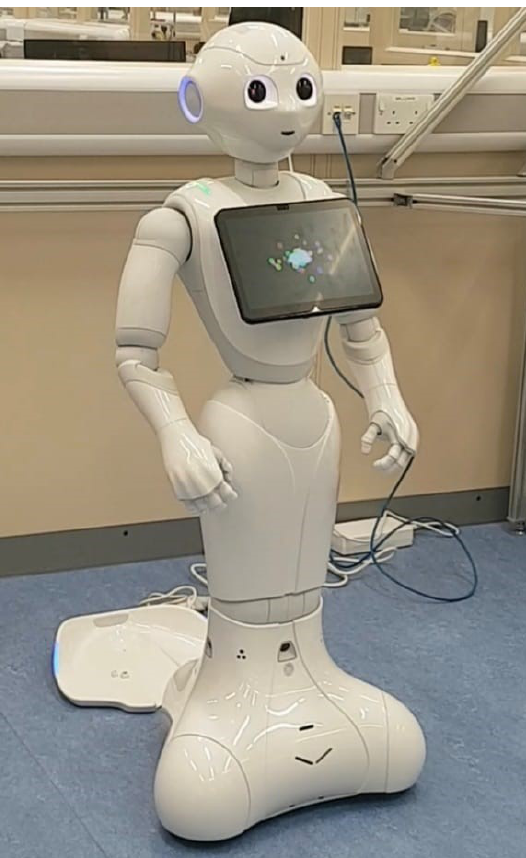
Figure 1. Social robot